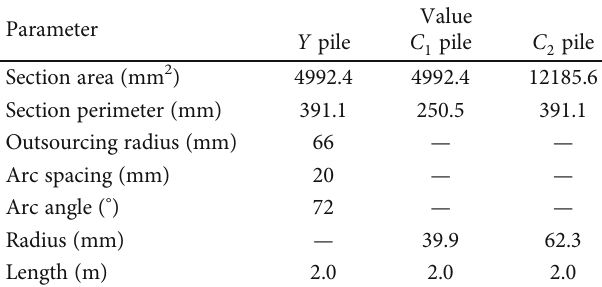
Table 3: Model pile